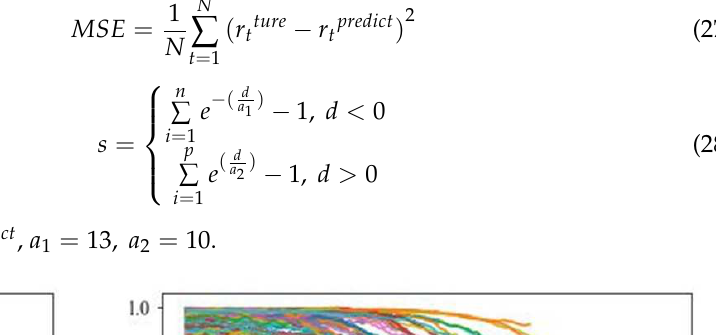
Figure 13. STL decomposition modeling result.